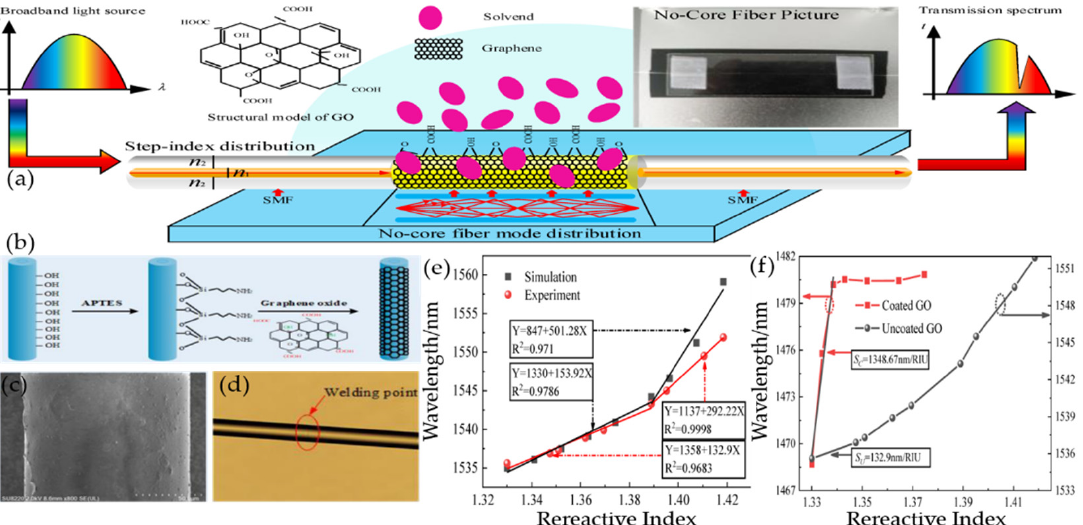
Figure 8. ( a ) Schematic diagram of the GO-sensitized SNS sensor. ( b ) Flow chart of GO production ( c ) SEM image of GO-coated fiber sensor. ( d ) Micrograph of solder joint. ( e ) Sensitivity and linearity at different RI wavelengths (simulated and experimental). ( f ) The relationship between the characteristic wavelength and the refractive index of the coated and uncoated GO. Reproduced from [101] with permission of the Multidisciplinary Digital Publishing Institute.